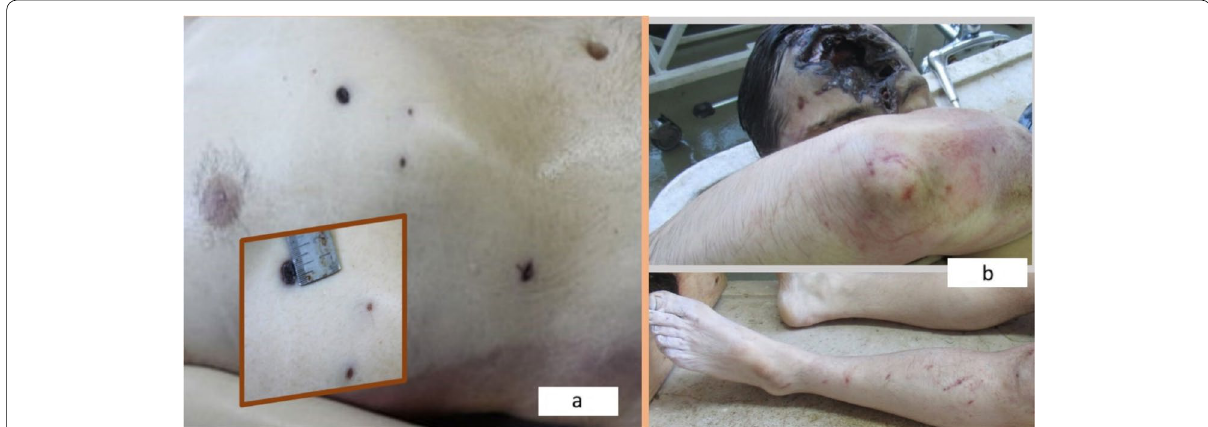
Fig. 3 The superficial stab wounds of the torso ( a ); bruises and abrasions of the limbs ( b